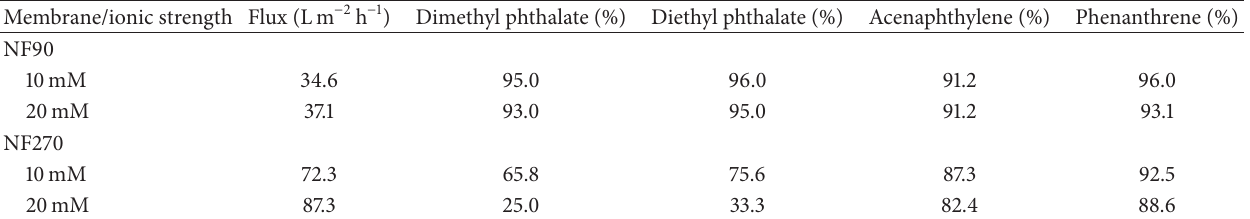
Table 4: Effect of ionic strength on rejection of compounds by the two NF membranes (transmembrane pressure 500 kPa, pH 7.5; initial concentration of compounds 0.5–0.8 mgL − 1 ).